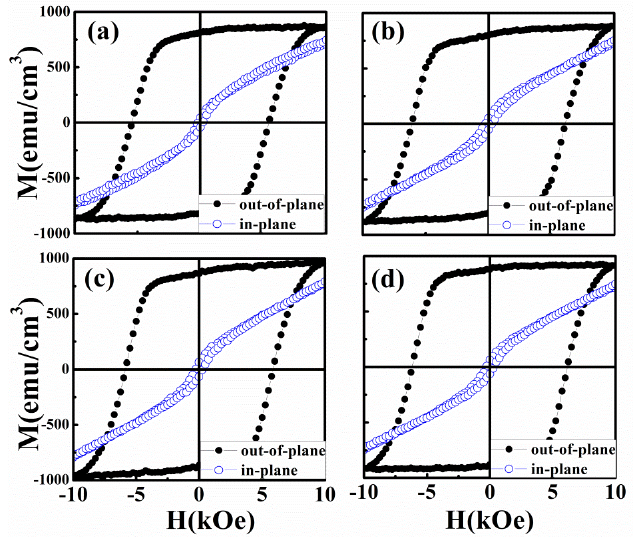
Figure 7. Out-of-plane and in-plane field-dependent magnetization loops of CoCrPt / y / NiW / NiTa, here y is ( a ) Ru, ( b ) RuCoCr, ( c ) RuCoCrTi, and ( d ) RuCoCrRe intermediate layer.